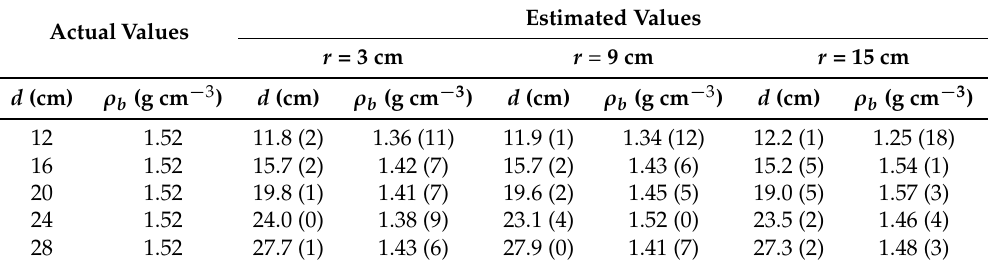
Table 1. Simultaneously-estimated depths and soil densities for disk sources of different radii buried at different depths in dry soil. The values in parentheses are the relative error in